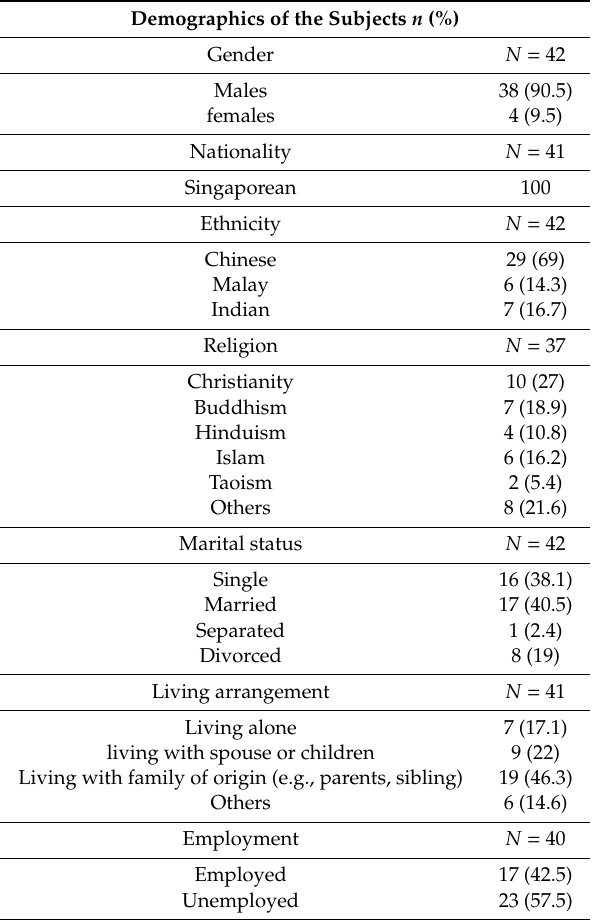
Table 1. Socio-demographic characteristics of the